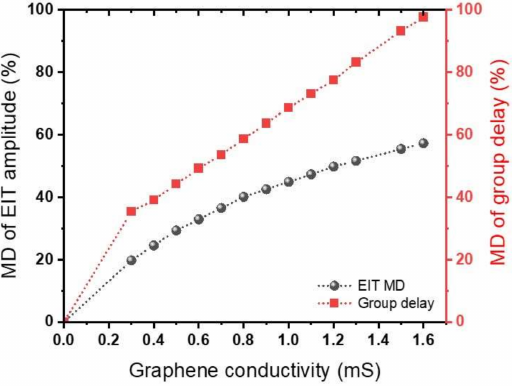
Figure 9. Modulation depth (MD) of the EIT and group delay as a function of graphene conductivity at f = 0.541 THz and T = 4.5